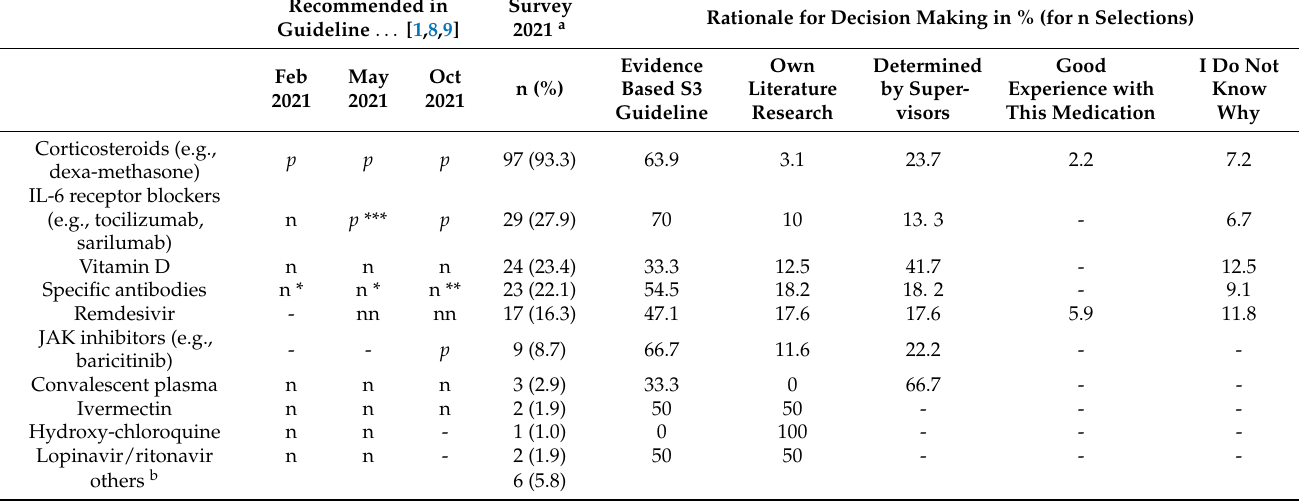
Table 5. Recomendations from 3 guideline versions in 2021, frequencies of usage and rationale for